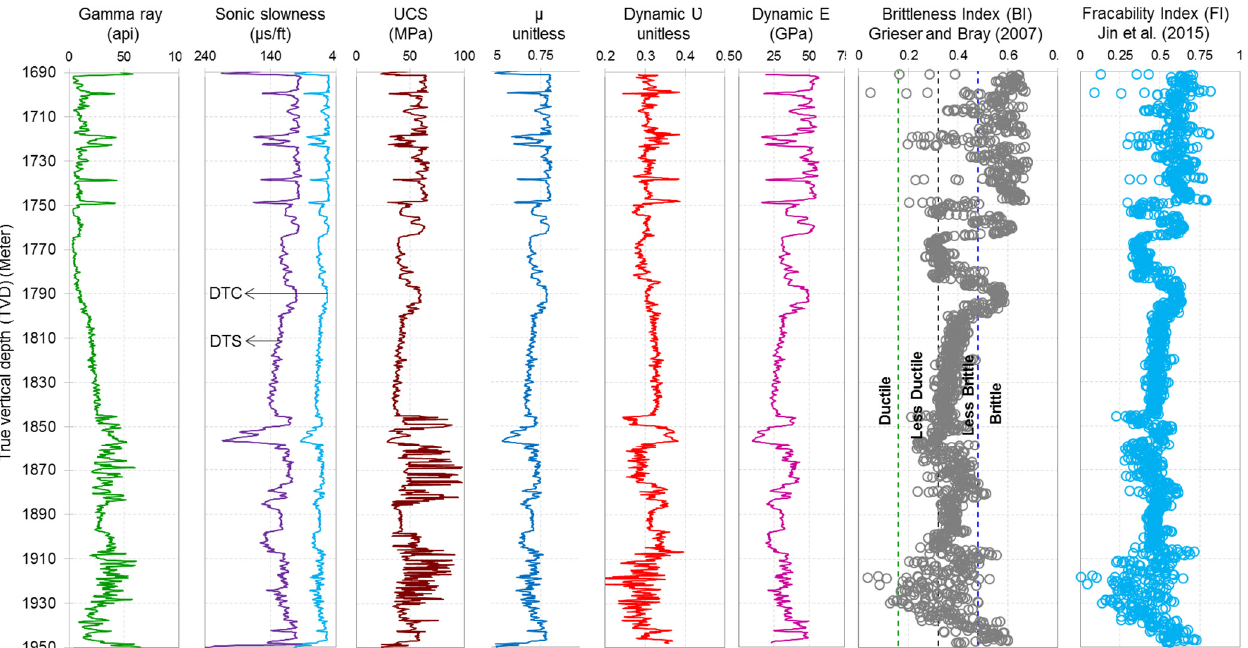
Figure 5. Estimated unconfined compressive strength (UCS), coefficient of internal friction ( µ ), Poisson’s ratio ( υ ), Young’s modulus (E), brittleness index (BI), and Fracability index (FI) of the studied Turonian carbonate interval in Well-1. BI is modeled following Grieser and Bray [22] and FI is estimated as per Jin et al. [23].